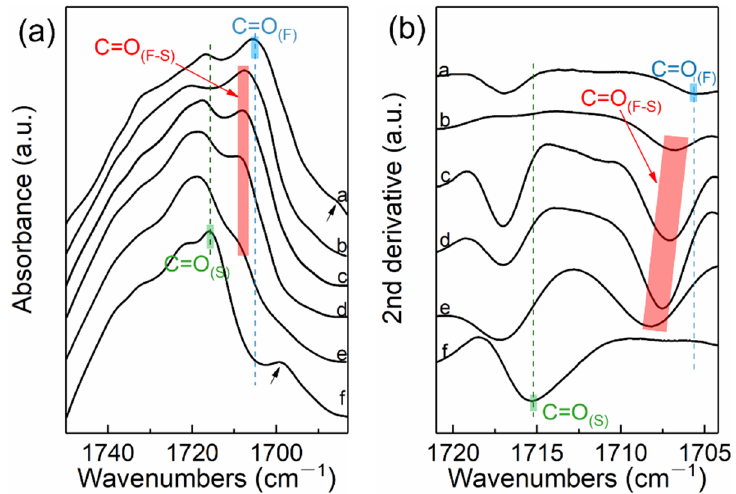
Figure 5. FTIR spectra of PBS ‐ UPy, PBF ‐ UPy and their blends in the wavenumber range of 1750– 1685 cm –1 ( a ) and their second derivative spectra ( b ). Spectra a–f correspond to PBF ‐ UPy, PBS ‐ UPy/PBF ‐ UPy ‐ 20/80, PBS ‐ UPy/PBF ‐ UPy ‐ 40/60, PBS ‐ UPy/PBF ‐ UPy ‐ 60/40, PBS ‐ UPy/PBF ‐ UPy ‐ 80/20, and PBS ‐ UPy, respectively.